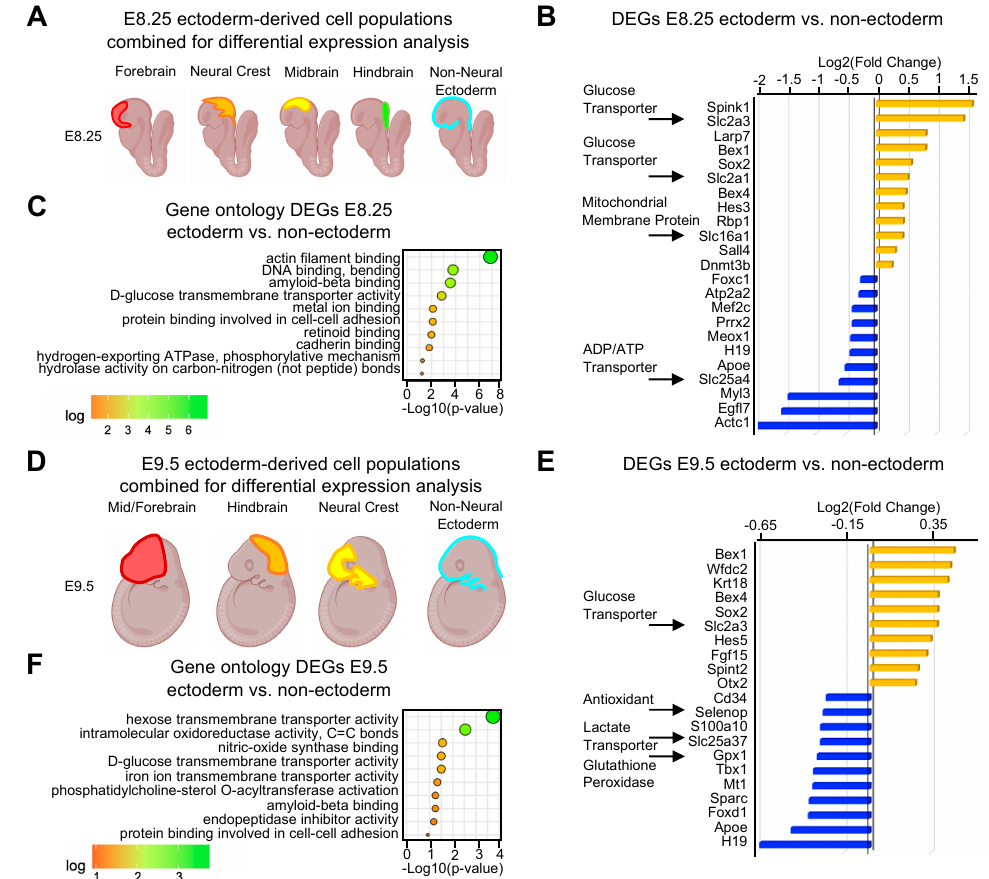
Figure 1. Metabolism and di ff erentiation are coupled during neurulation. ( A ) Di ff erential expression of ectoderm derived cell populations grouped together and compared to the non-ectoderm-derived cells at E8.25. ( B ) Bar plot showing the top up- and downregulated genes at E8.25. Arrows point out metabolic genes. ( C ) Dot plot showing molecular gene ontology of di ff erentially expressed genes at E8.25. ( D ) Di ff erential expression of ectoderm-derived cell populations grouped together and compared to the non-ectoderm-derived cells at E9.5. ( E ) Bar plot showing top up- and downregulated genes at E9.5. Arrows point out metabolic genes. ( F ) Dot plot showing molecular gene ontology analysis of di ff erentially expressed genes at E9.5.